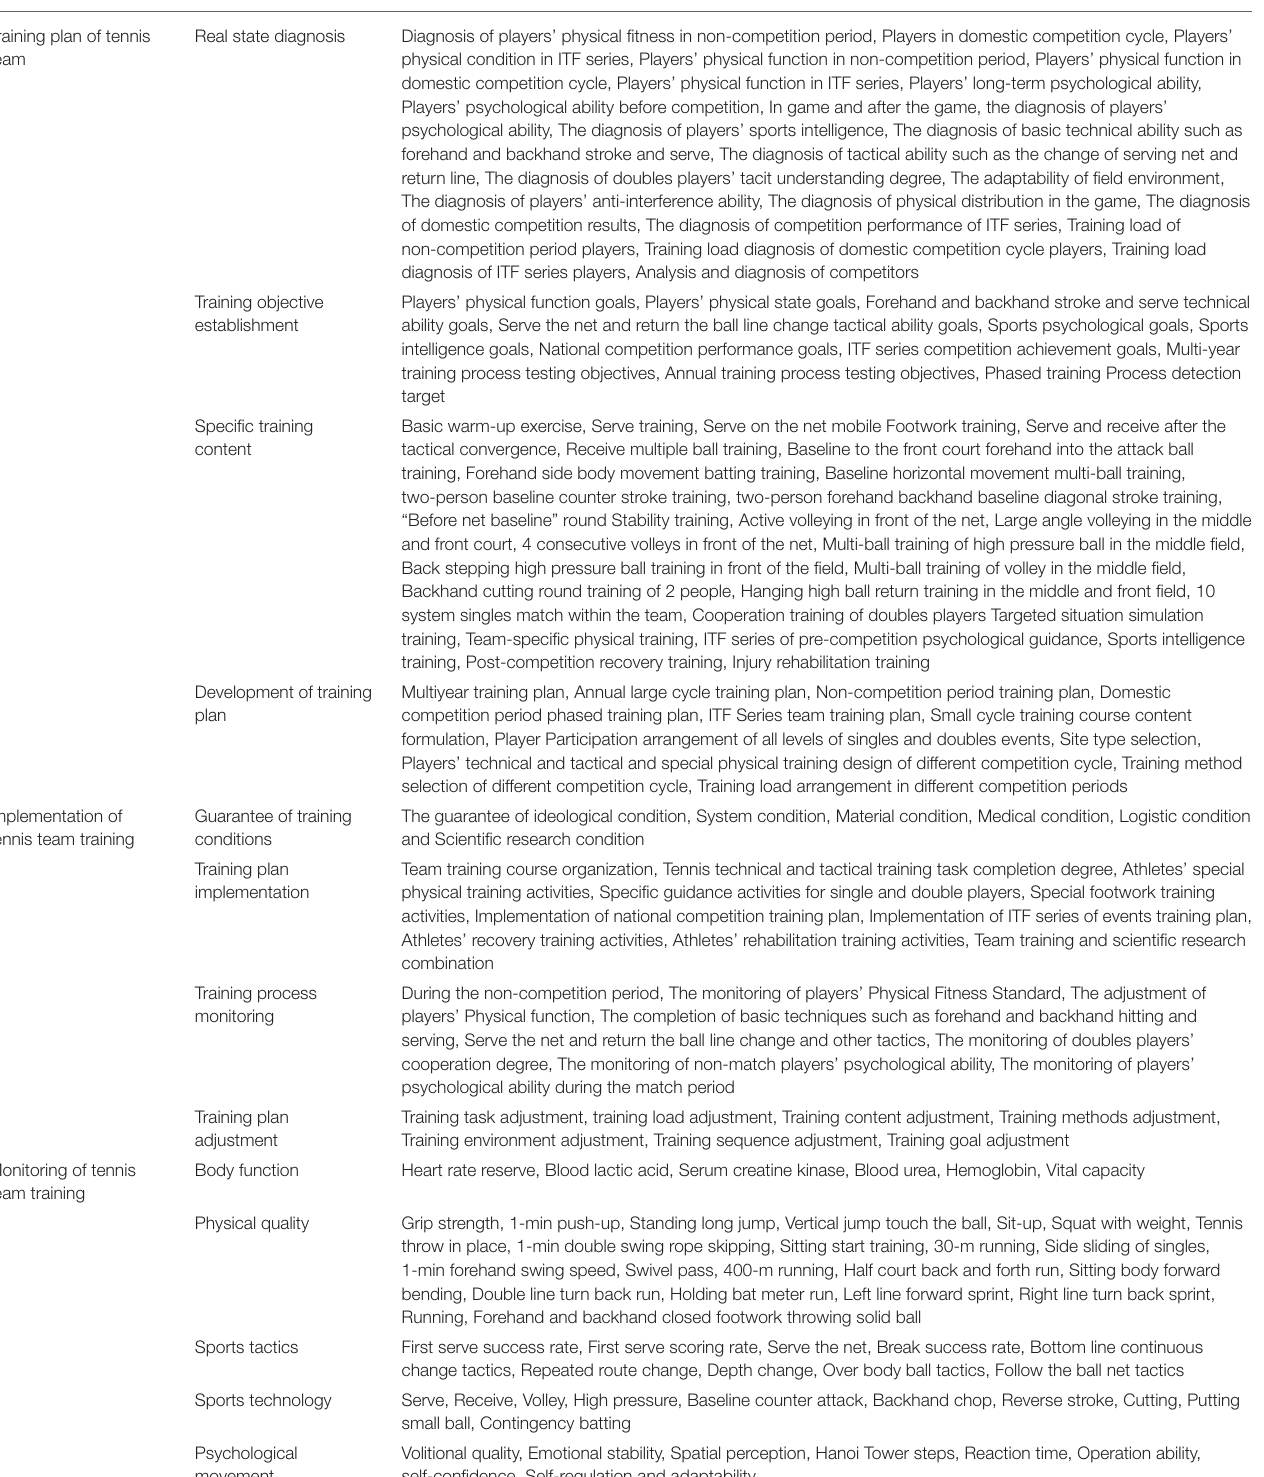
TABLE 9 | List of primary selection indexes for training quality evaluation of high-level tennis teams. Primary